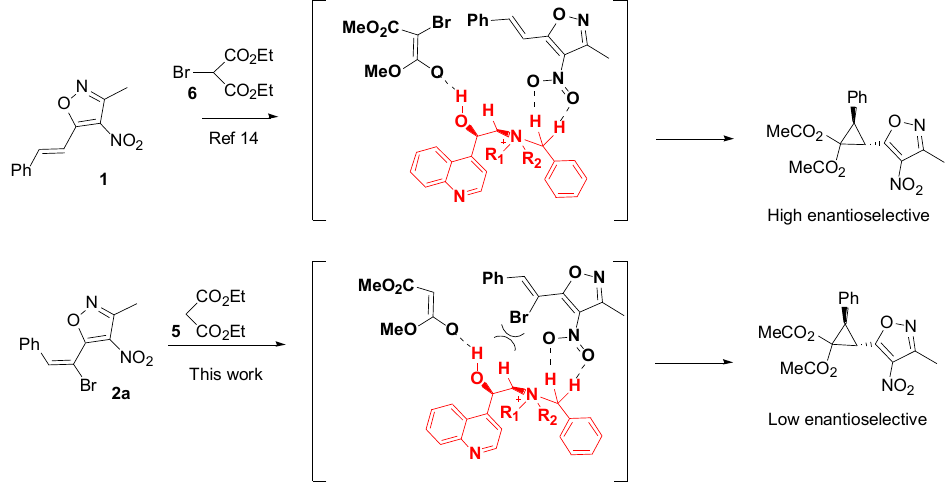
Figure 2. Proposed transition states for the cyclopropanation of 1 and 2